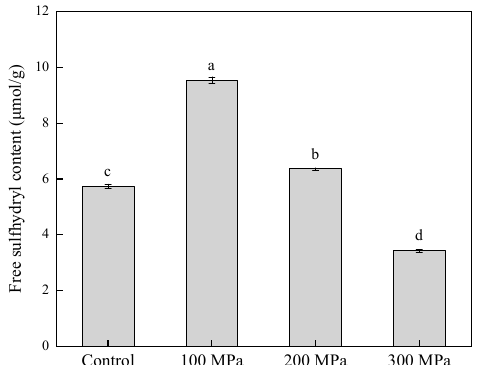
Figure 7. Effect of HHP pretreatment on the free sulfhydryl content of RBPH. HHP: high hydrostatic pressure; RBPH: rice bran protein hydrolysates. Control, 100 MPa, 200 MPa, and 300 MPa represent RBPH samples subjected to 0, 100, 200, and 300 MPa pretreatment, respectively. Different letters indicate values that differ significantly ( p < 0.05). All the HHP pretreatments were conducted at 25 °C for 30 min.